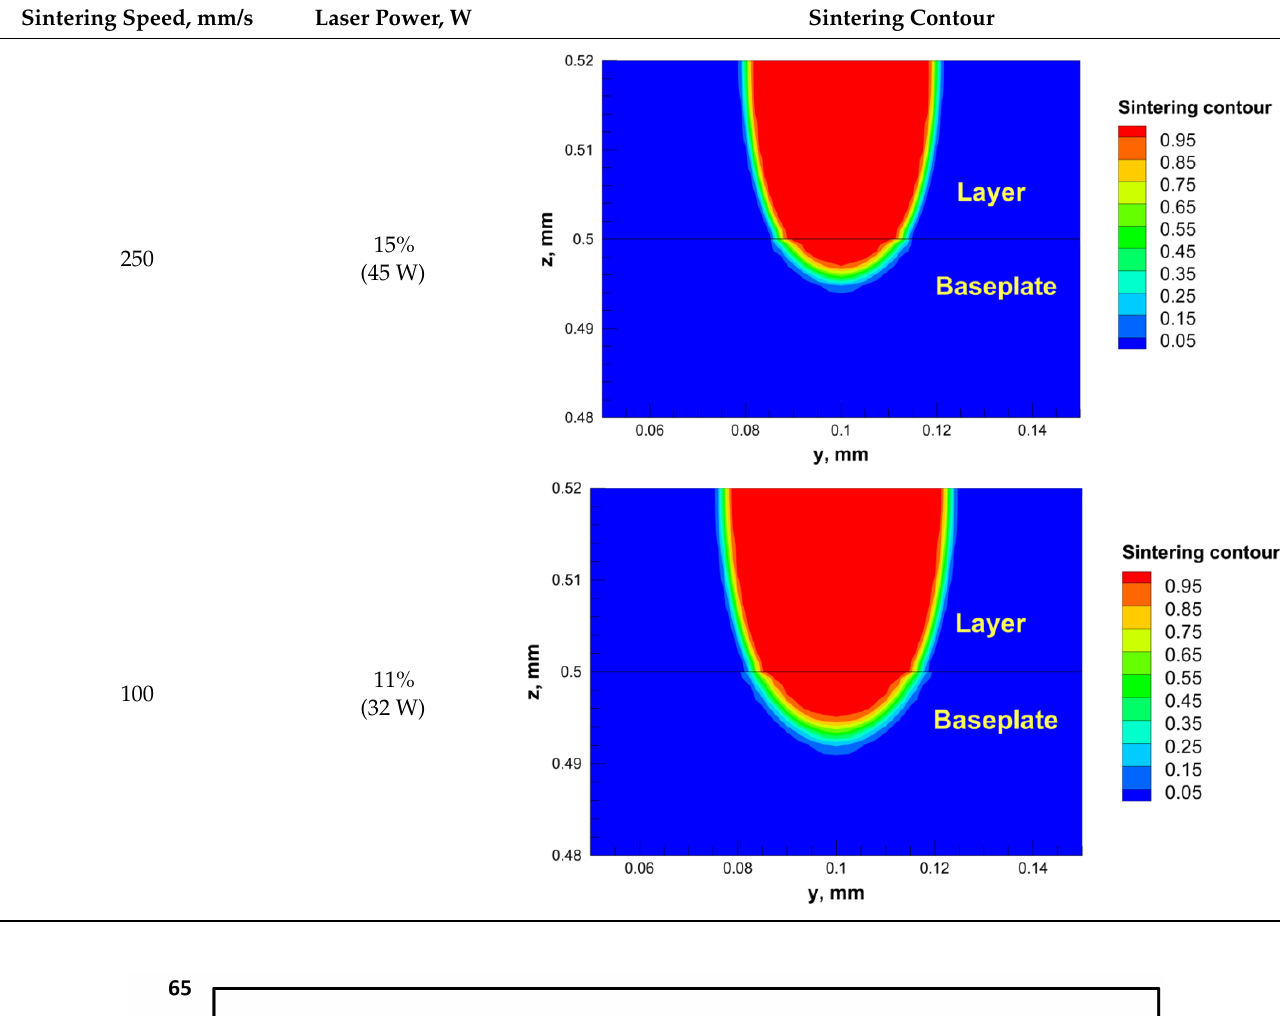
Table 4. Laser power selection for sintering speeds of 250 and 100 mm/s.